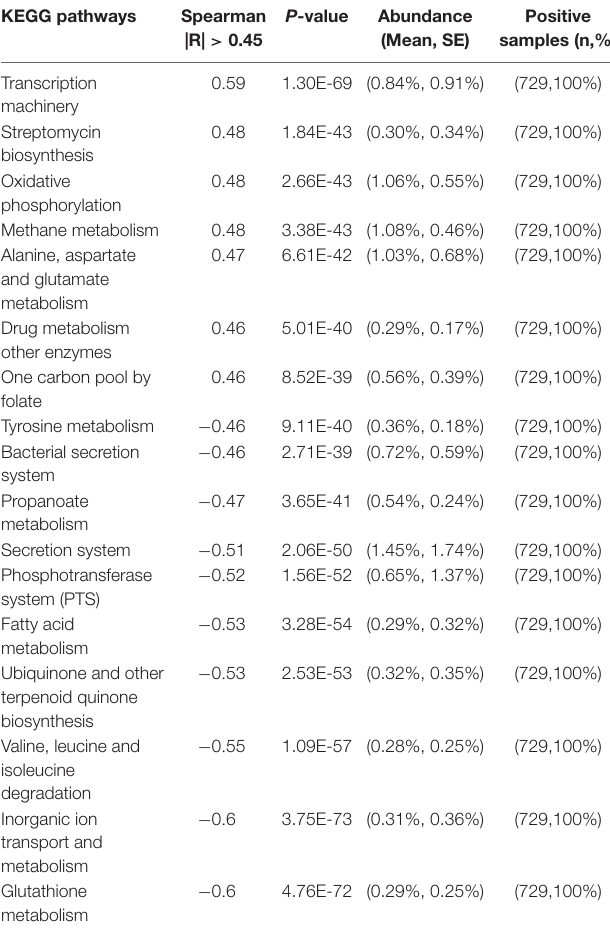
TABLE 3 | Predicted functions of the gut microbiome that significantly correlate with